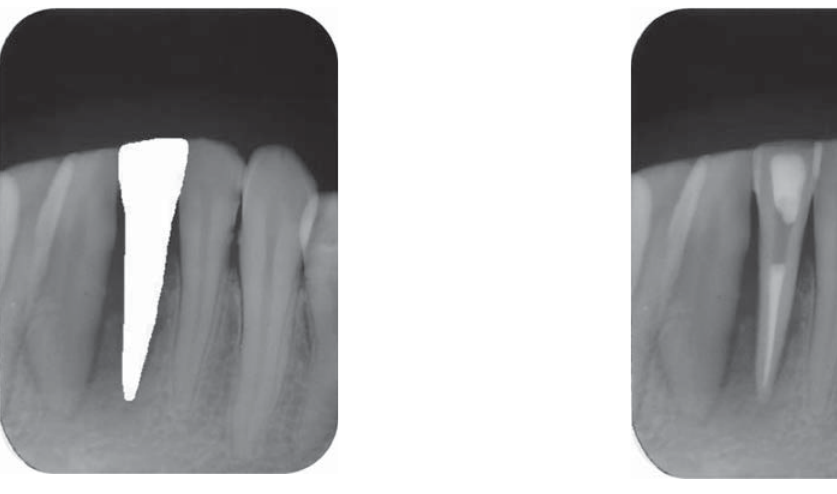
Figure 2- Analysis II (only periapical areas are visible) Figure 3- Analysis III (unedited Table 1- (cid:4)(cid:6)=(cid:16)(cid:22)(cid:27)((cid:22)(cid:17)C(cid:12)(cid:4)(cid:9)(cid:20)(cid:27)(cid:27)(cid:16)(cid:23)(cid:22)(cid:13)(cid:18)(cid:20)(cid:17)(cid:4)(cid:9)(cid:20)(cid:16)(cid:29)(cid:21)(cid:9)(cid:18)(cid:16)(cid:17)(cid:13)(cid:4)*(cid:27)<(cid:4);(cid:16)(cid:13)H(cid:16)(cid:16)(cid:17)(cid:4)(cid:12)(cid:9)(cid:20)(cid:27)(cid:16)(cid:12)(cid:4)(cid:22)(cid:12)(cid:12)(cid:18)!(cid:17)(cid:16)(cid:15)(cid:4)(cid:13)(cid:20)(cid:4)=(cid:22)(cid:27)(cid:13)(cid:18)(cid:22)(cid:23)(cid:4)(cid:20)(cid:27)(cid:4)(cid:9)(cid:20)(=(cid:23)(cid:16)(cid:13)(cid:16)(cid:4)(cid:27)(cid:22)(cid:15)(cid:18)(cid:20)!(cid:27)(cid:22)=(cid:11)(cid:18)(cid:9)(cid:4)(cid:18)((cid:22)!(cid:16)(cid:4)(cid:22)(cid:17)(cid:22)(cid:23)(cid:28)(cid:12)(cid:18)(cid:12)